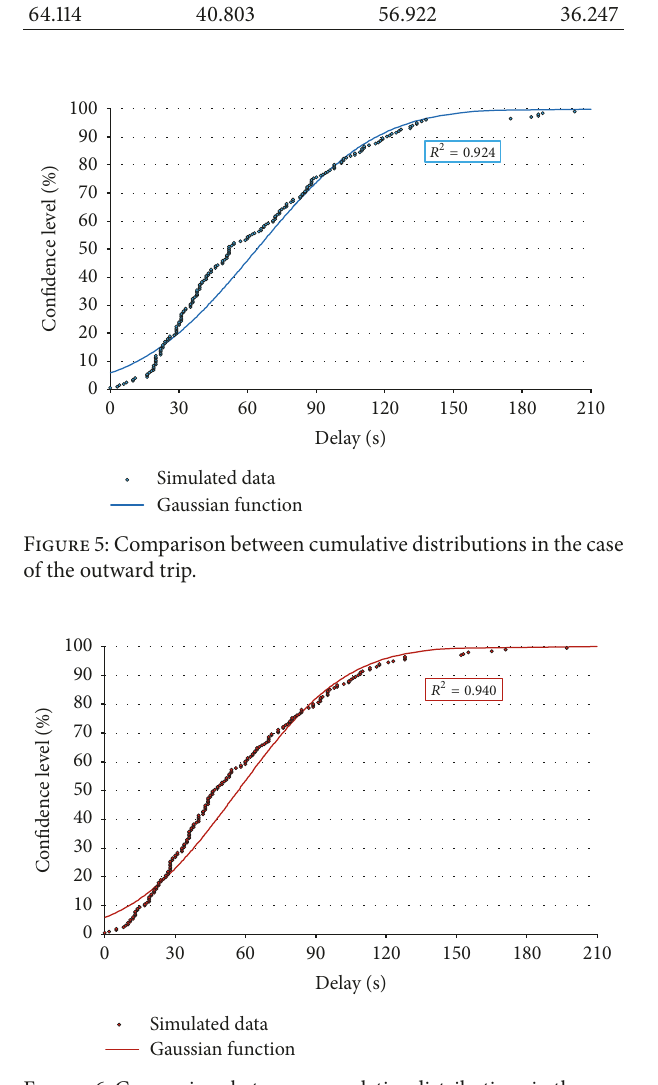
Figure 6: Comparison between cumulative distributions in the case of the return